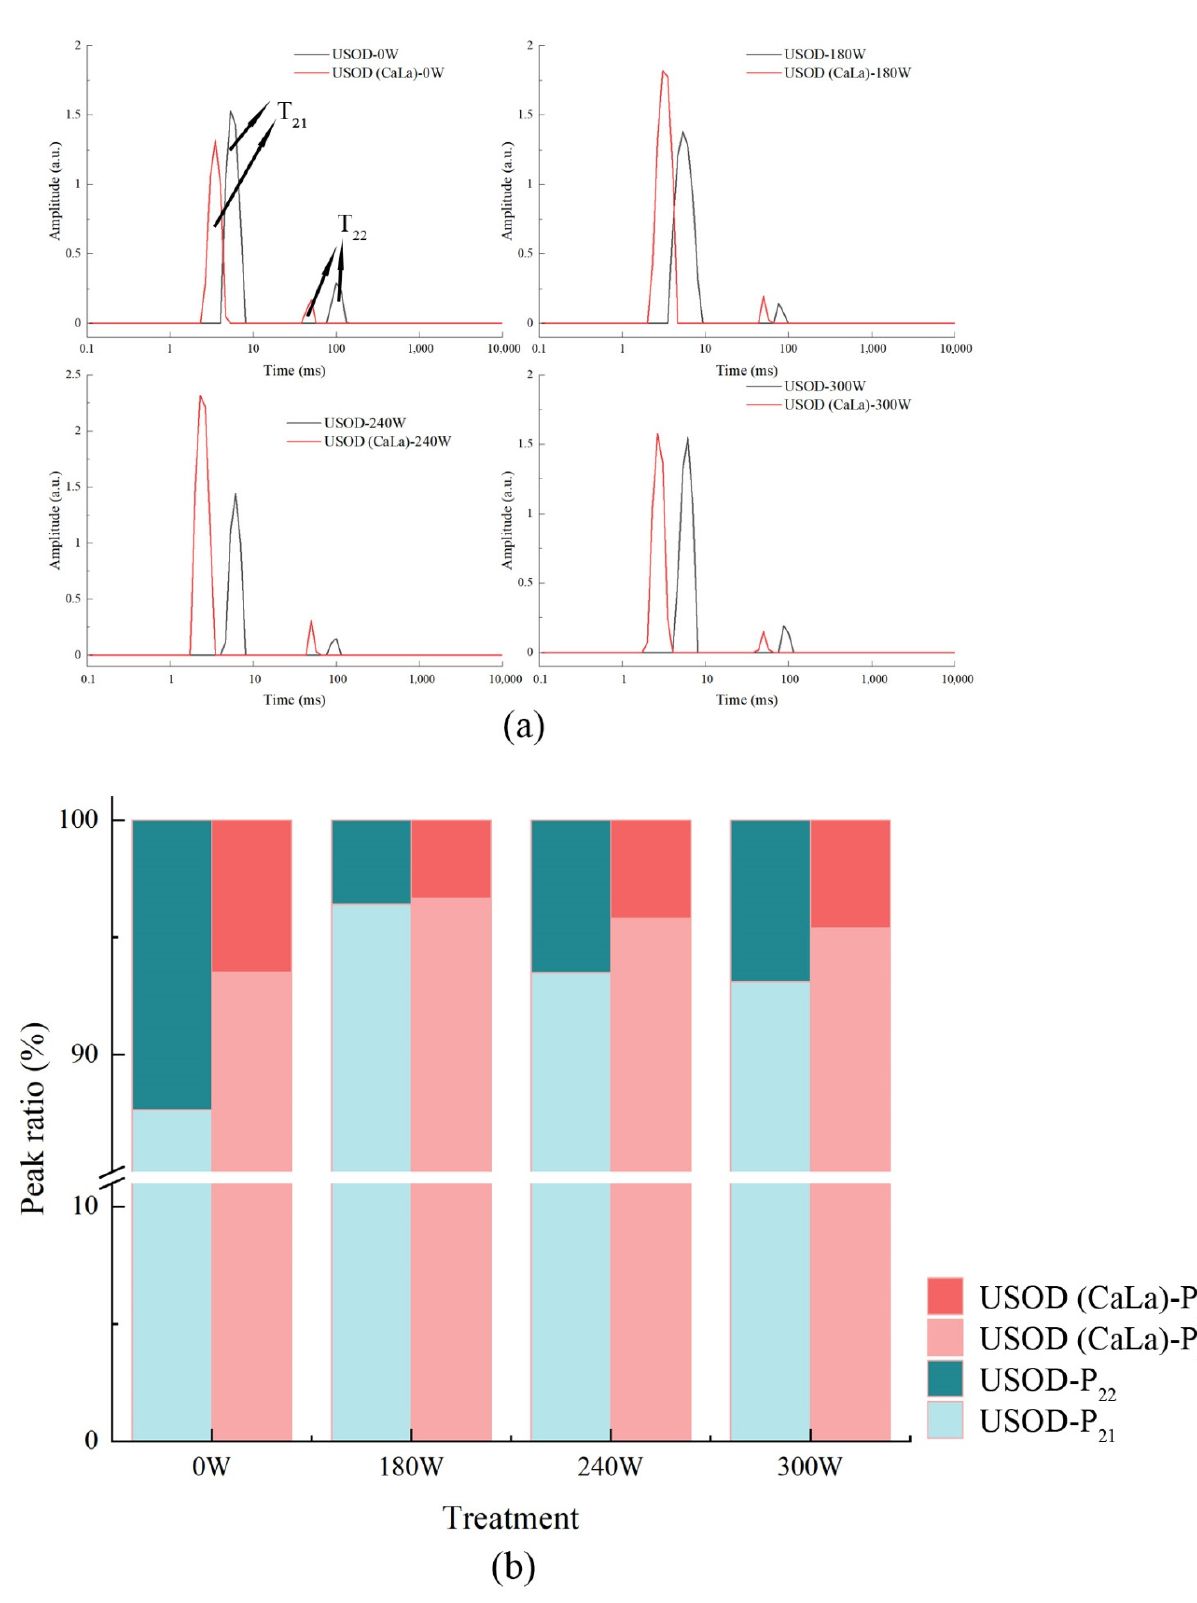
Figure 2. T 2 relaxation time ( a ) and peak ratio ( b ) of freeze-dried yellow peach slices with different treatments.